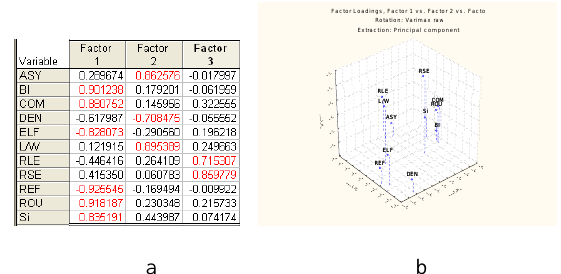
Figure 7. a) Factor loadings after varimax rotation of three factors. b) 3D presentation of the values of factor loadings of the first (X axis), the second (Y axis) and the third factor (Z axis) from a.